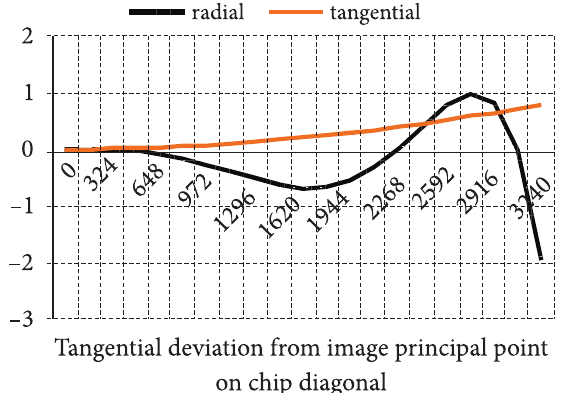
Fig. 3. A lens distortion differential diagram between two calibration methods